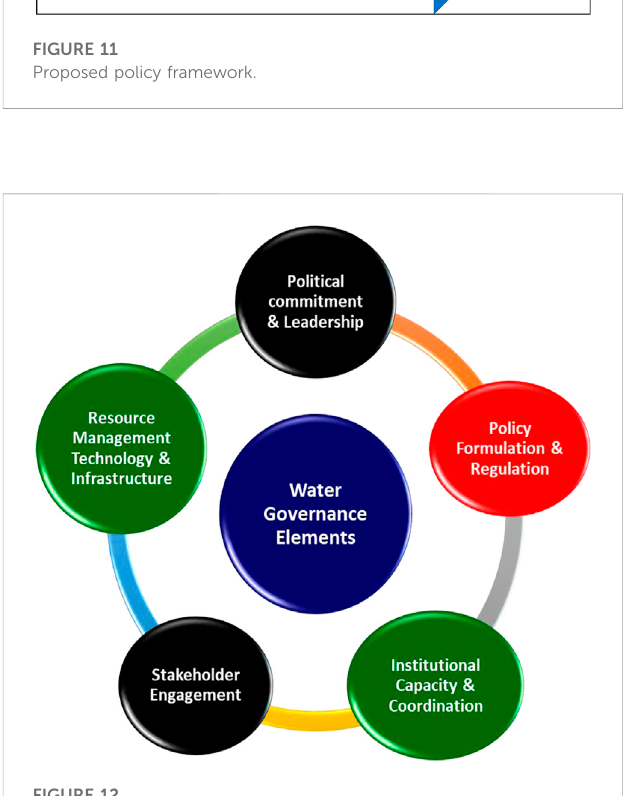
FIGURE 12 Elements of the proposed water governance